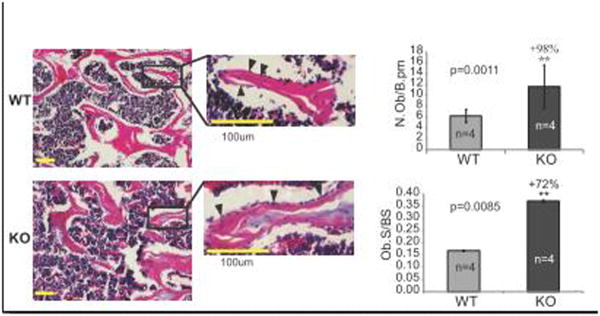
Histology and histomorphometry analyses(A, B) Representative H&E stained lumbar vertebrae (L4) from 6.5-month-old male mice. (C, D) Enlarged images showing the boxed areas in A and B. (E, F) Quantitative results showing the numbers of osteoblasts and the osteoblast covered bone surfaces.